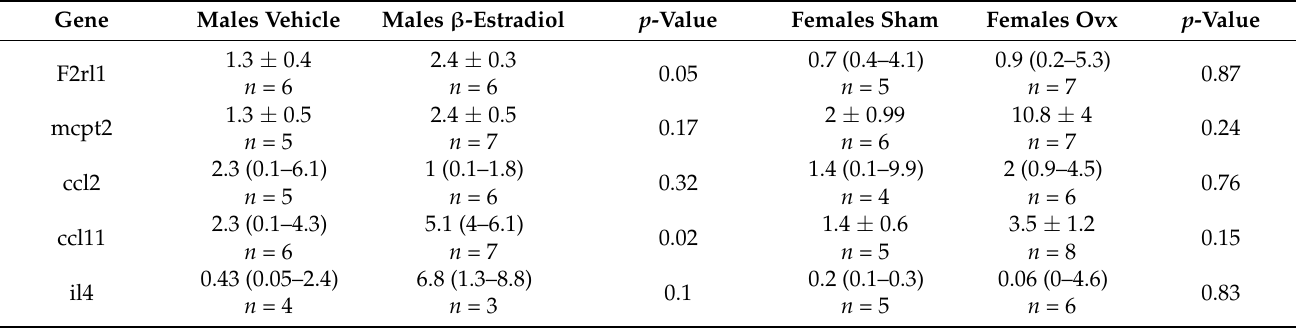
Figure 6. Effect of estrogen in MS males on colonic sensitivity. Colonic sensitivity was assessed by testing the elevation of linear regression curves using a Fisher test between MS males before and after 3 injections of vehicle ( n = 7) ( A ), between MS males before and after injections of β -estradiol ( n = 7) ( B ), and between MS males injected with vehicle and MS males injected with β -estradiol ( C ). Individual representation of the effect of the treatment tested with a two-way ANOVA comparing paired time point ( D ). * p < 0.05. VMR—visceromotor response. n = 7–10 per group. Table 1. Effect of β -estradiol on gene expression of jejunal mucosal inflammatory